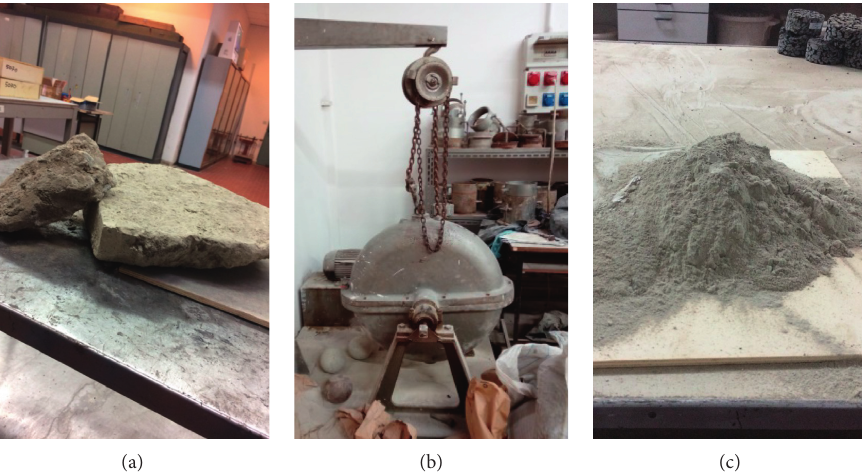
Figure 2: Jet grouting waste before and after the grinding process. (a) Before grinding. (b) Grinding device. (c) After grinding. Table 2: Binder properties: (a) neat bitumen 50/70, (b) bituminous emulsion 60/40, and (c) bitumen contained in bituminous emulsion. Properties